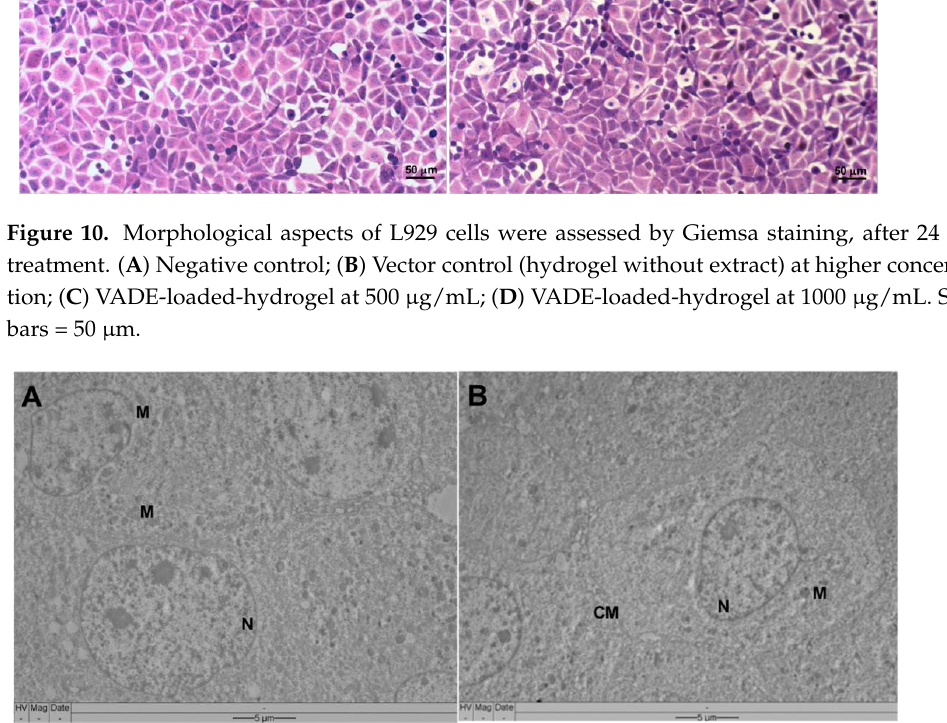
Figure 11. Morphological changes of L929 cells were assessed by transmission electron microscopy, after 24 h of treatment. ( A ) Negative control; ( B ) VADE-loaded-hydrogel at 500 µg/mL of extract. M: Mitochondria; N: nucleus; CM: cytoplasmatic membrane. Scale bars: 5 µm.